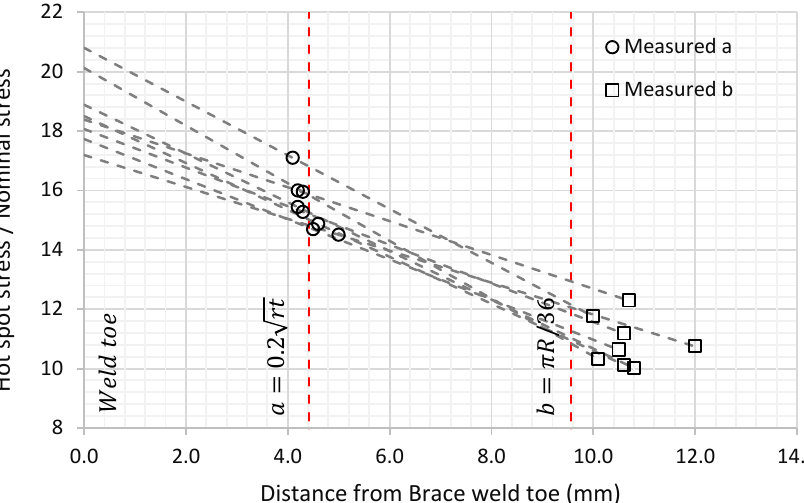
Figure 10. Experimentally measured SCFs sensitivity.